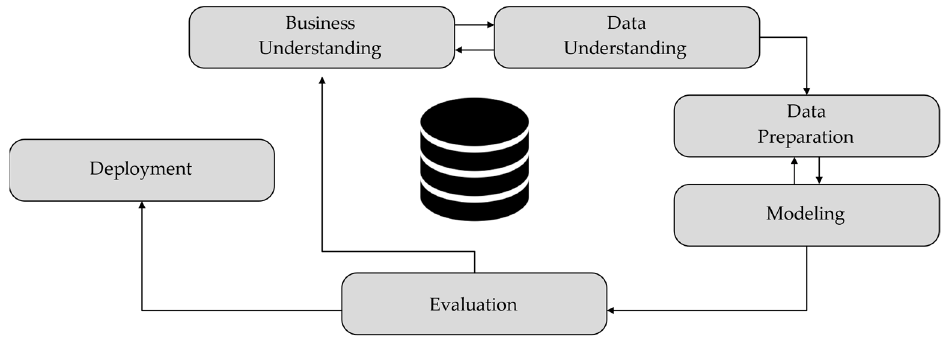
Figure 1. Six stages of CRISP-DM.